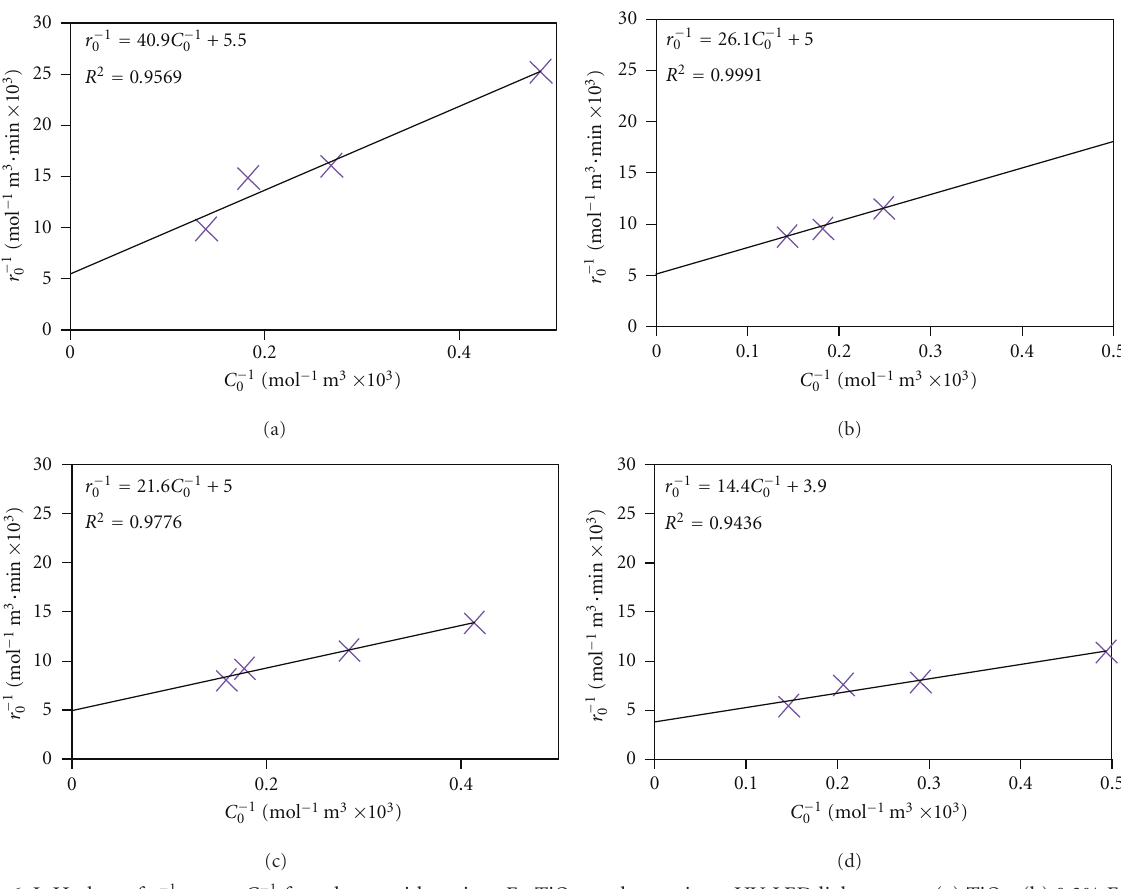
Figure 6: L-H plots of r − 1 0 versus C − 1 0 for toluene with various Fe-TiO 2 catalysts using a UV-LED light source. (a) TiO 2 , (b) 0.3% Fe-TiO 2 , (c) 0.5% Fe-TiO 2 , and (d) 0.7% Fe-TiO 2 .